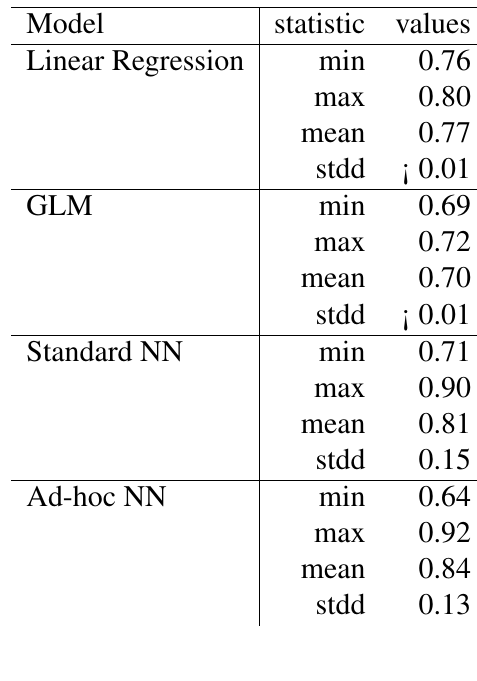
Table 6: Experiments with Linear Regression, Generalised Linear Models, and Neural Networks (Standard and Ad-hoc). Statistics of the R-Squared computed on the test sets of 50 different training/testing